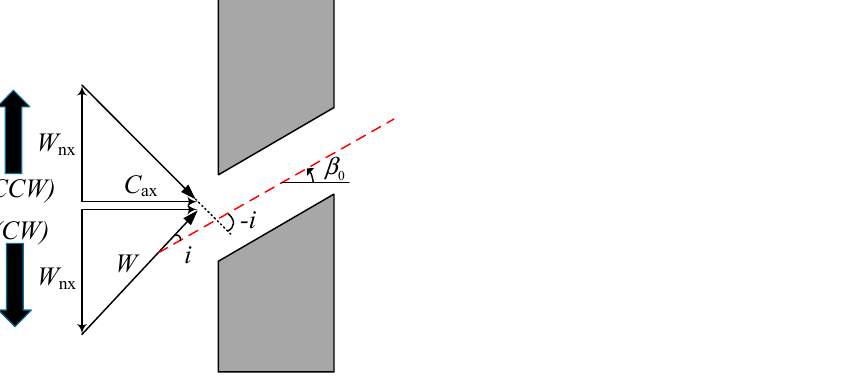
Figure 15. Comprehensive incidence angle at different orientations of the rotational speed. The combined effect of rotation, circumferential inclination angle, and flow parame- ters on the discharge coefficient can be more clearly represented by the method of the comprehensive incidence angle. According to Equation (12), the formula for calculating the comprehensive incidence angle of the orifice with only the circumferential inclination angle is given by